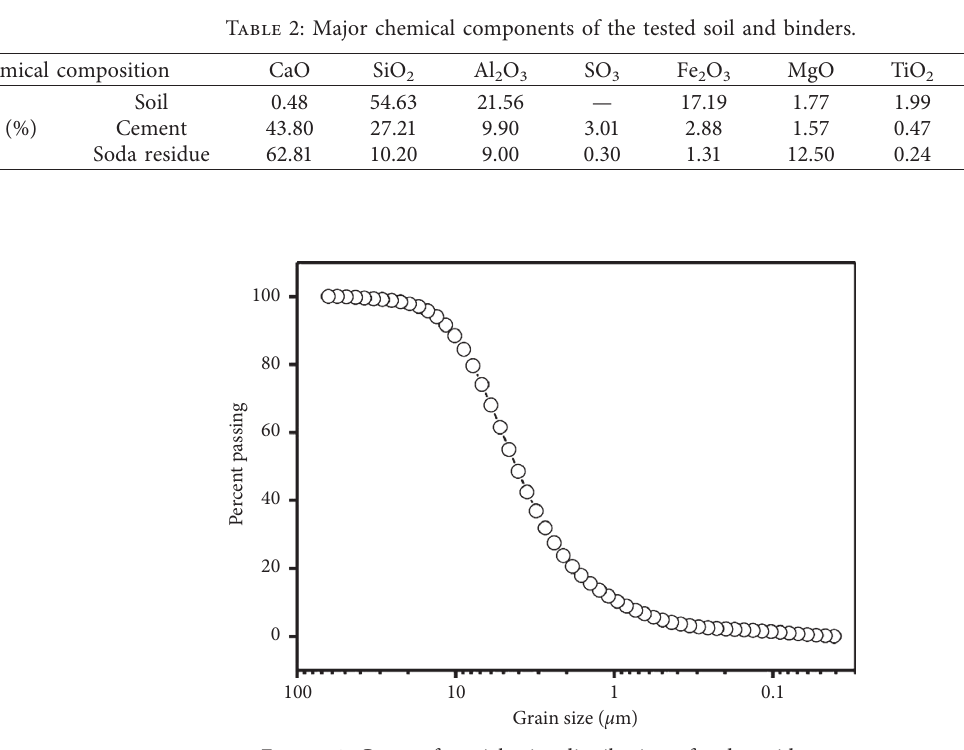
Figure 1: Curve of particle size distribution of soda